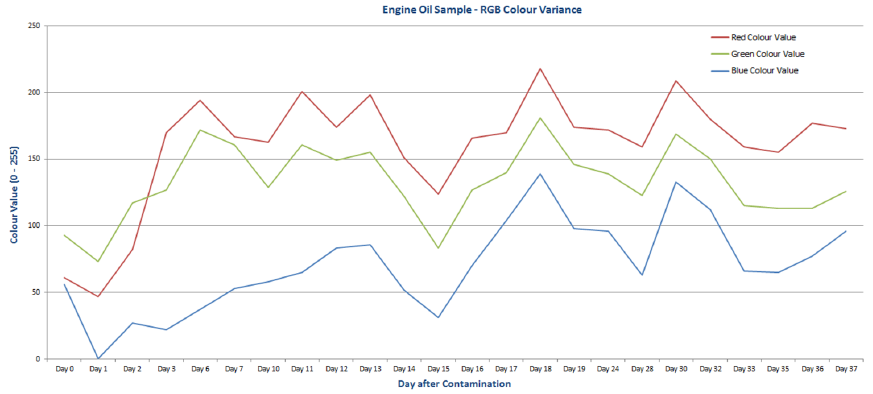
RGB colour values plotted as a function of time after contamination with engine